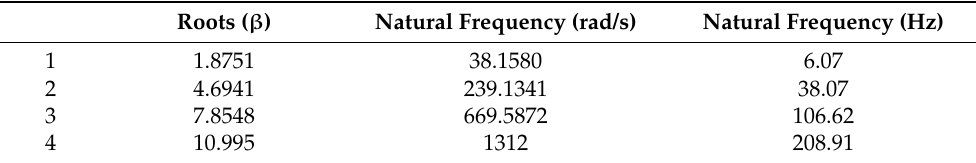
Table 1. The obtained four natural frequencies for the drill pipe.